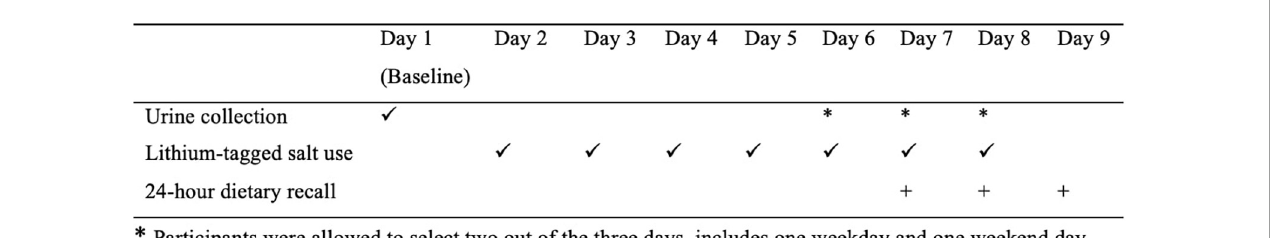
FIGURE1 Overview of the study. ∗ Participants were allowed to select two out of the 3 days, includes one weekday and one weekend day. + 24-h dietary recall performed on the day after 24-h urine